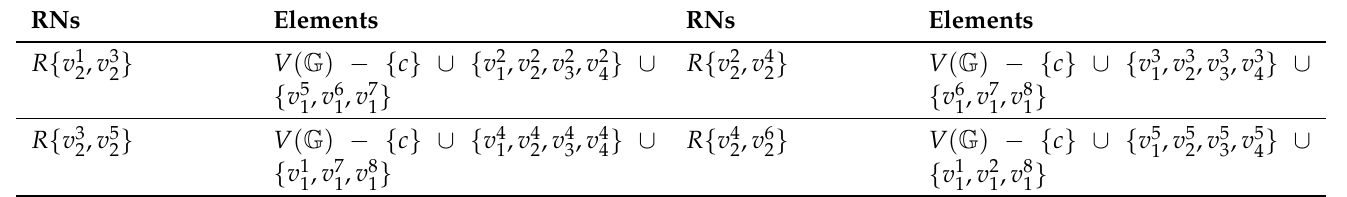
Table 13. RNs ´ R u for 33 ≤ u ≤ 36 and 2 ≤ j ≤